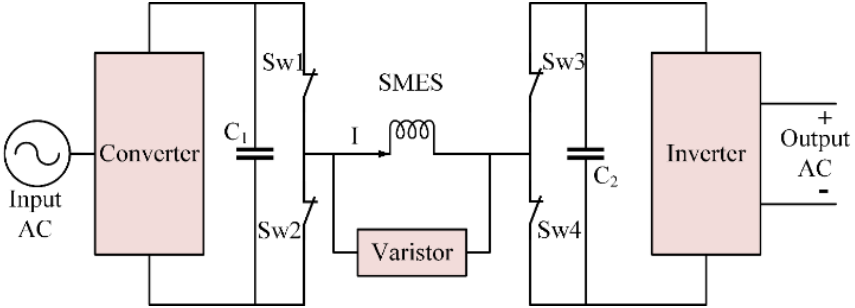
Figure 19. Electrical circuit of the SMES, comprising of an inverter, two DC link capacitors, a converter,